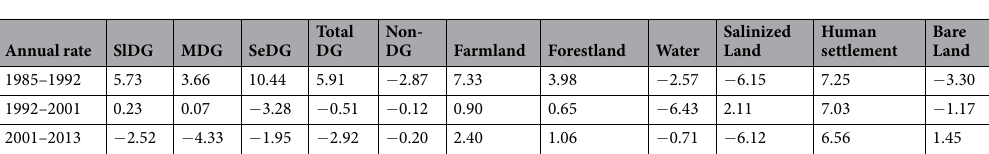
Table 3. Annual change rates for each major category in the Horqin Sandy Land over different periods (units: %). Positive values represent an increase, and negative values represent a